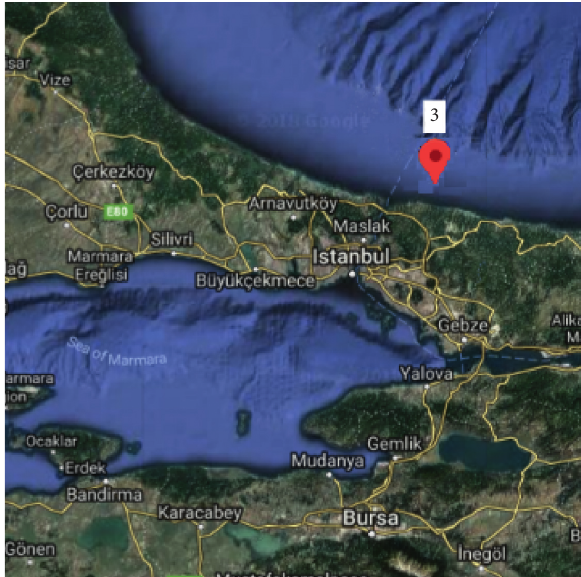
Figure 4: Sampling collection from Istanbul coast of Black Sea (41 ° 21 ′ N, 29 ° 34 ′ E).